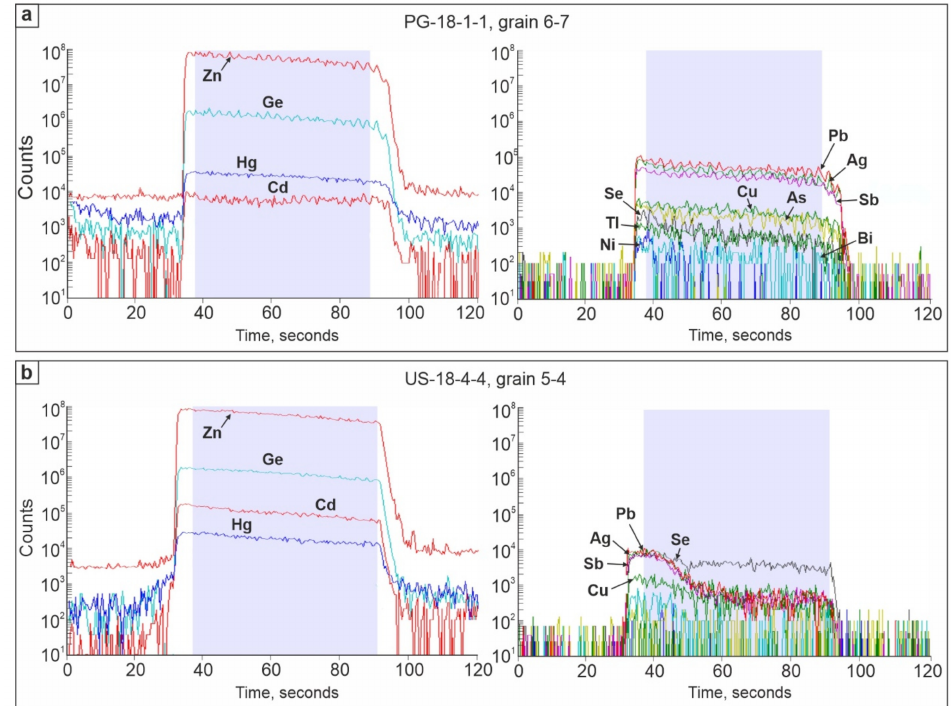
Figure 15. Representative single-spot LA-ICPMS spectra (blue shading) for selected elements in homogenous low-Hg sphalerites without mineral inclusions ( a ) and with Pb-Sb-Cu-(Ag) sulfosalt micro-scale inclusion ( b ). For sphalerite compositions, see Tables 4 and